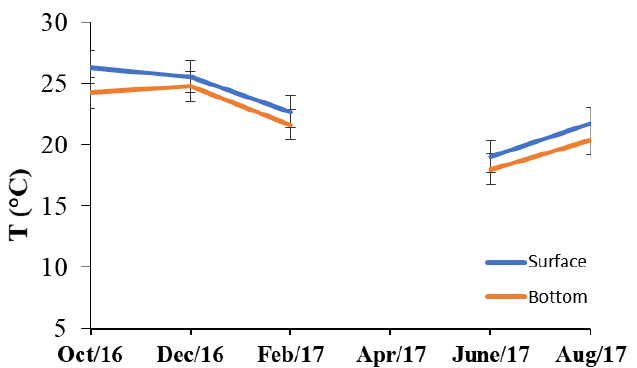
Figure 3. Water temperature variation according to the sampling depth in Lake Paranoá along the study time.